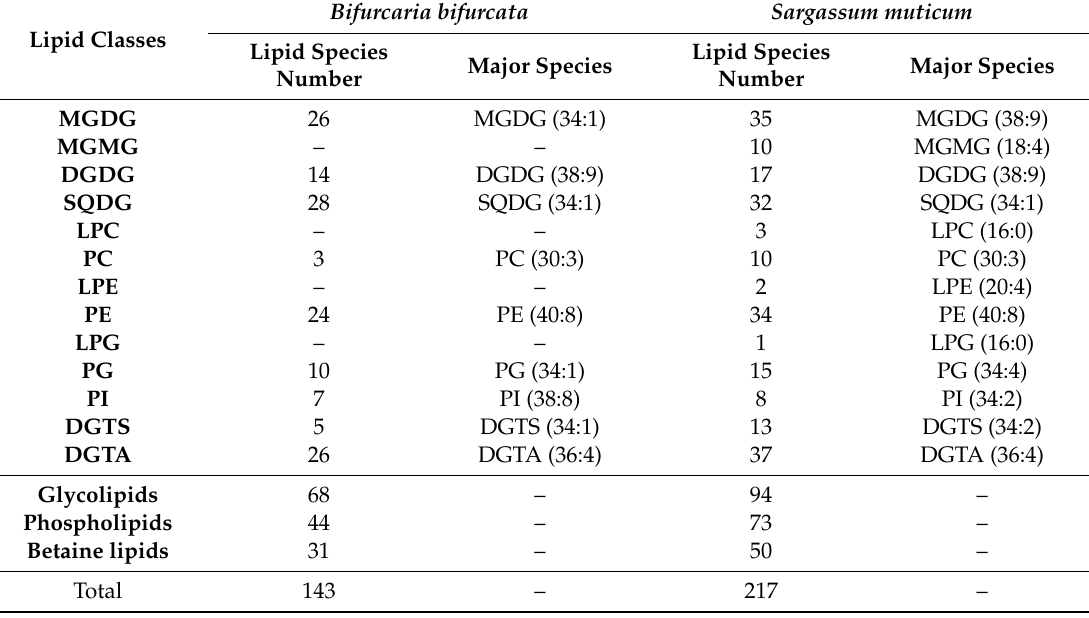
Table 2. Polar lipid classes identified by hydrophilic interaction liquid chromatography-high resolution mass spectrometry (HILIC LC–MS) in total lipid extracts of B. bifurcata and S. muticum with the indication of the total number of lipid species identified in each class and the major lipid species per